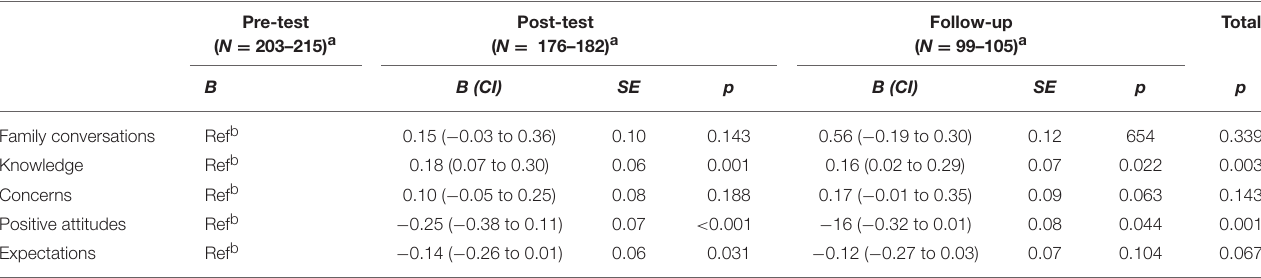
TABLE 3 | Multivariate analyses of variance of differences in having performed Family conversations, Knowledge, Expectations, Positive attitudes, and Concerns according to measurement time (pre-test, post-test, and follow-up), adjusted by sex and